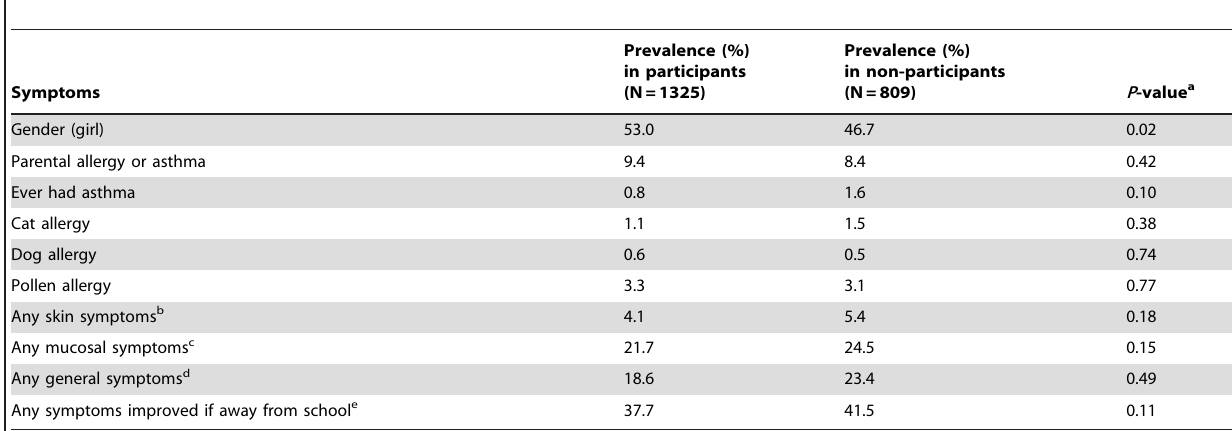
Table 1. Demographic data from baseline study (2010) comparing questionnaire data for participants (N =1325) and non- participants (N= 809) in the two-year follow-up